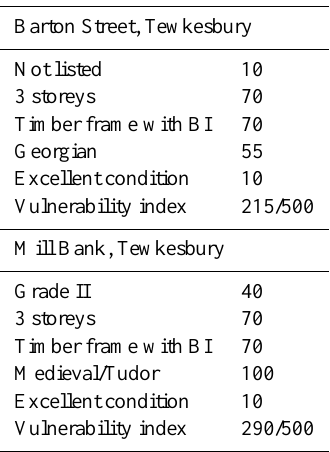
the most influential contributor to the listing of a structure. Table 2. Tewkesbury vulnerability index